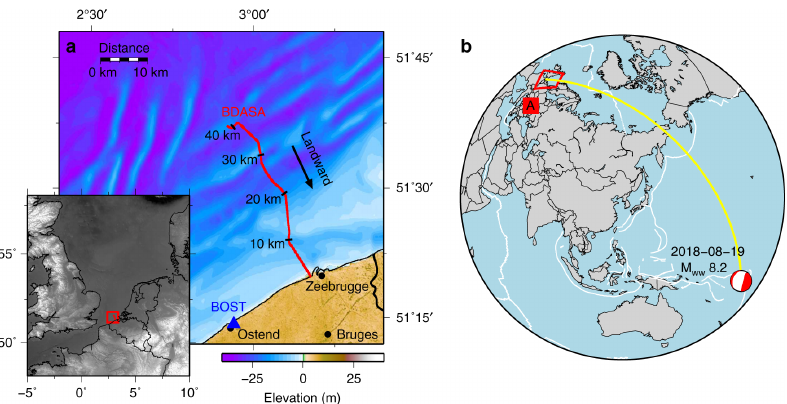
Figure 4. ( a ) The dark fiber cable (BDASA, Belgium Distributed Acoustic Sensing Array, red line) located at the Southern Bight of the North Sea offshore Zeebrugge, Belgium and used as a seismic array in [109] . ( b ) A world map showing the location of the BDASA (open red box, near the letter A), and the epicenter location (and Global Centroid Moment Tensor) of the 19 August 2018 Mw8.2 Fiji deep earthquake, which has been correctly detected by the DAS system. After